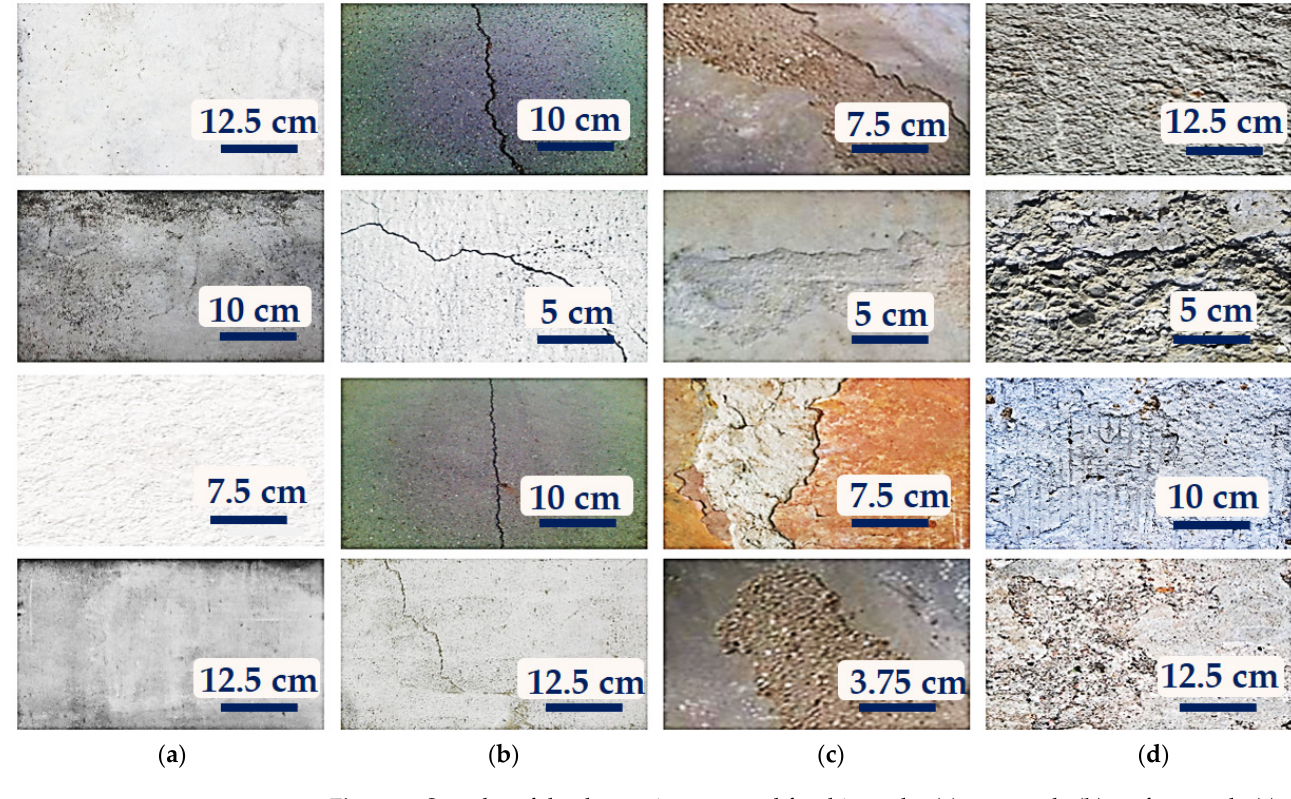
Figure 7. Samples of the dataset images used for this study: ( a ) non-crack; ( b ) surface crack; ( c ) de- lamination; and ( d ) spalling.